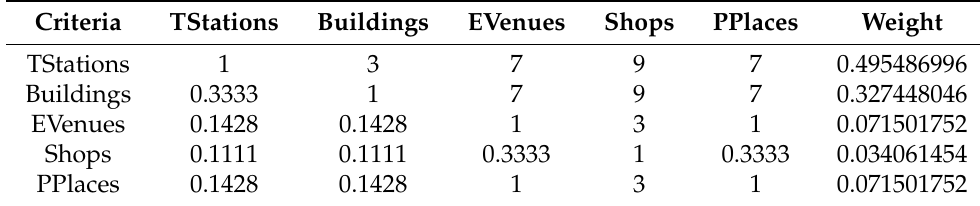
Table 7. Pairwise comparison matrix and computed criteria